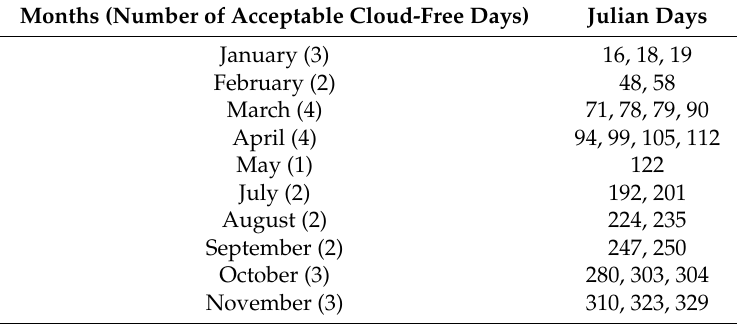
Table 2. Acceptable cloud-free days (i.e., 80% or more of the study site had no cloud cover) for the MODIS onboard the Terra satellite for the Southern Great Plains (SGP) during